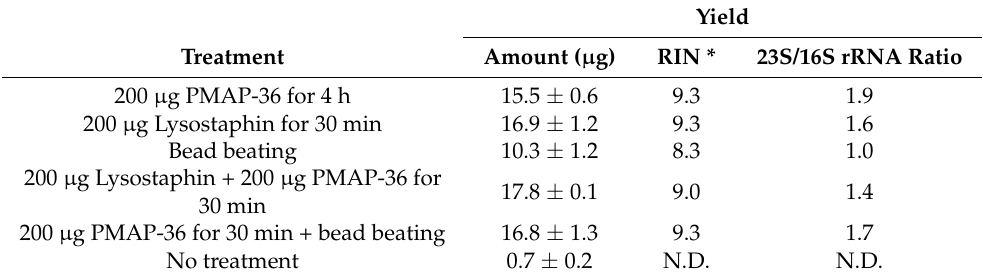
Table 3. Comparison of RNA yield from S. aureus using different cell wall lysis